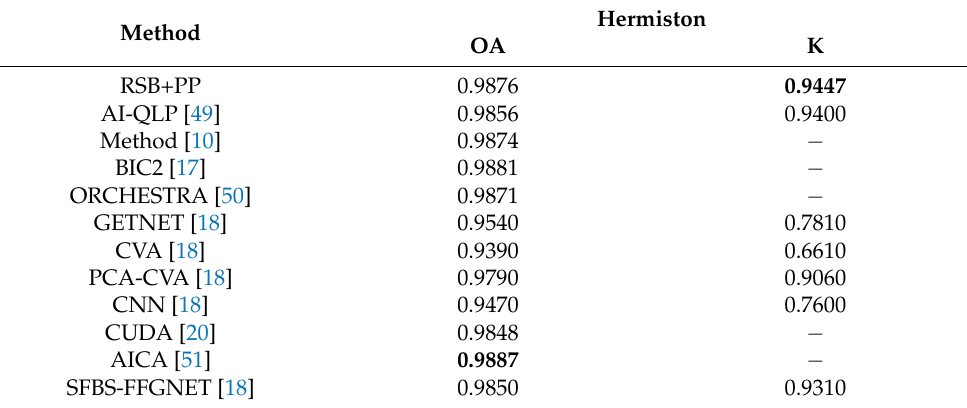
Table 3. The proposed approach, RSB, with post-processing, and other competitors on the Hermiston dataset. The best results are displayed in